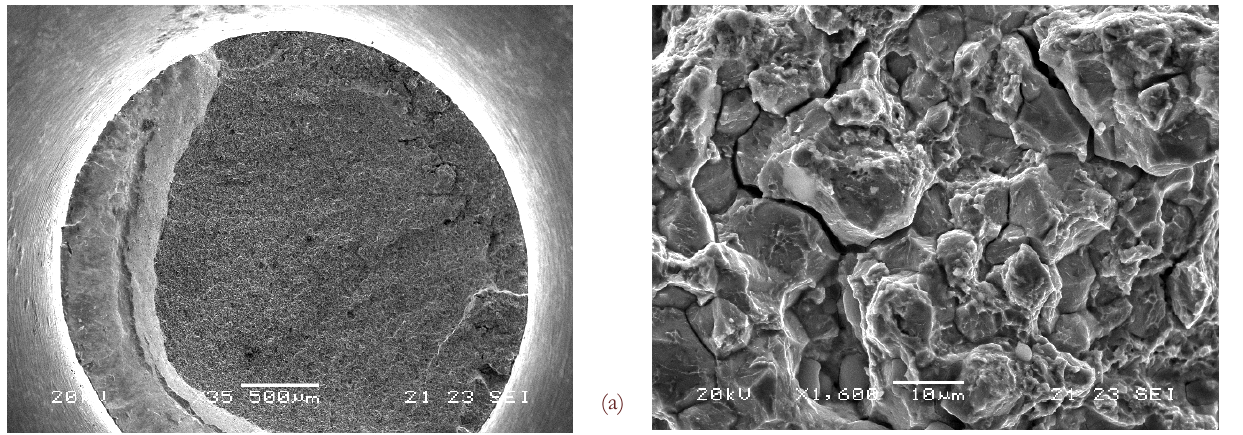
Figure 6: (a) Fracture surface for AISI 4340 specimen and (b) X1000 magnification for test with paint-stripper.